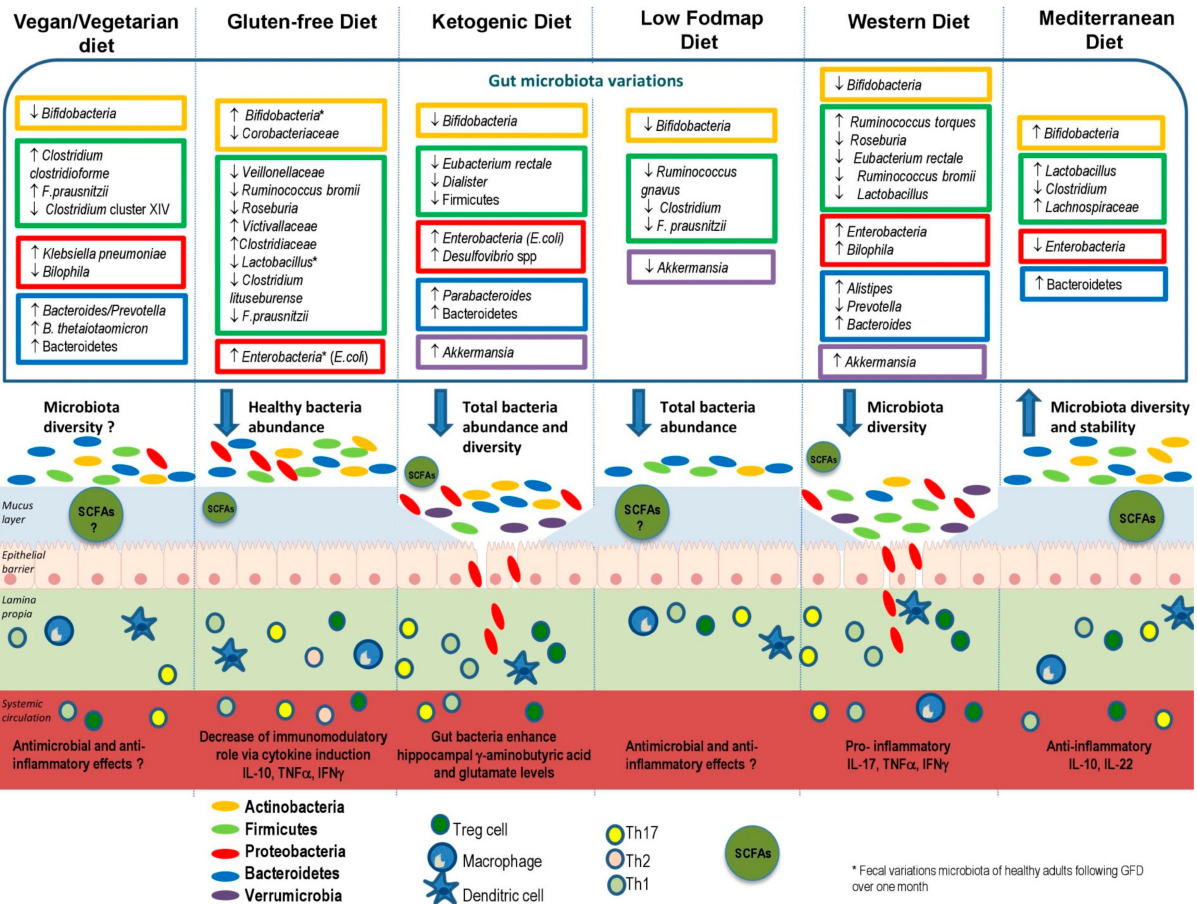
Figure 2. E ff ects of di ff erent types of diet on gut microbiota, mucus layer, and immune cells. Bacteria species variations are indicated in rectangular frames. The arrows pointing up or down respectively indicate an increase or decrease of bacteria abundance. Each color of the rectangular frames represents one phylum: yellow for Actinobacteria, green for Firmicutes, red for Proteobacteria, blue for Bacteroides, and purple for Verrumicrobia. In the illustration of the intestinal epithelium, oval shapes represent microbiota. Each color represents one phylum. Abbreviations: FODMAP: fermentable oligo-, di-, mono-saccharides, and polyols; GFD: gluten-free diet; SCFAs: short-chain fatty